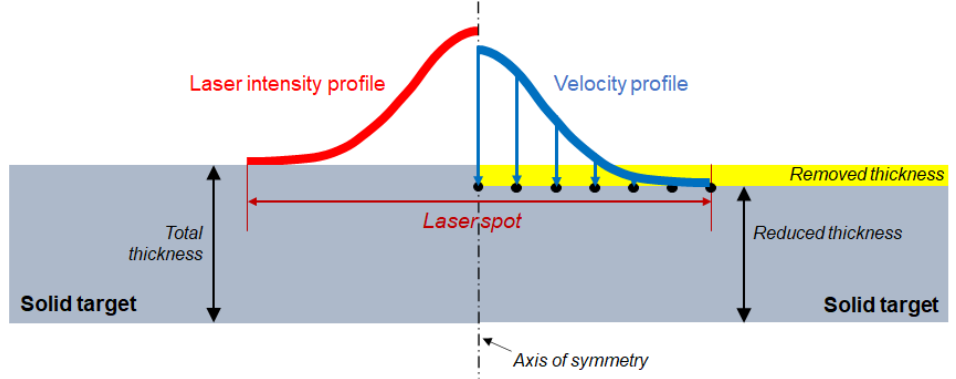
Figure 4. Schematic comparison between the actual phenomenon ( left side ) and the LS-Dyna model ( right side ).